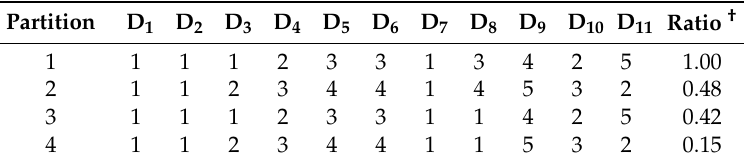
Table 4. Partitions selected by the Occam window.